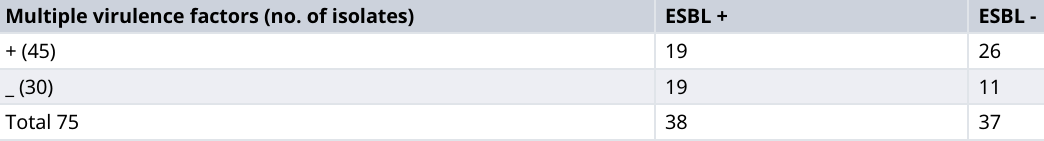
Multiple virulence factors (no. of